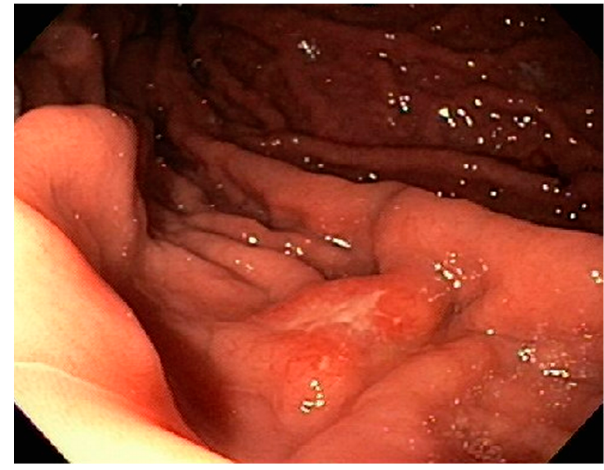
Diseases 2022 , 10 , x Figure 7. Clean based gastric ulcer noted on endoscopy. Figure 7. Clean based gastric ulcer noted on endoscopy.